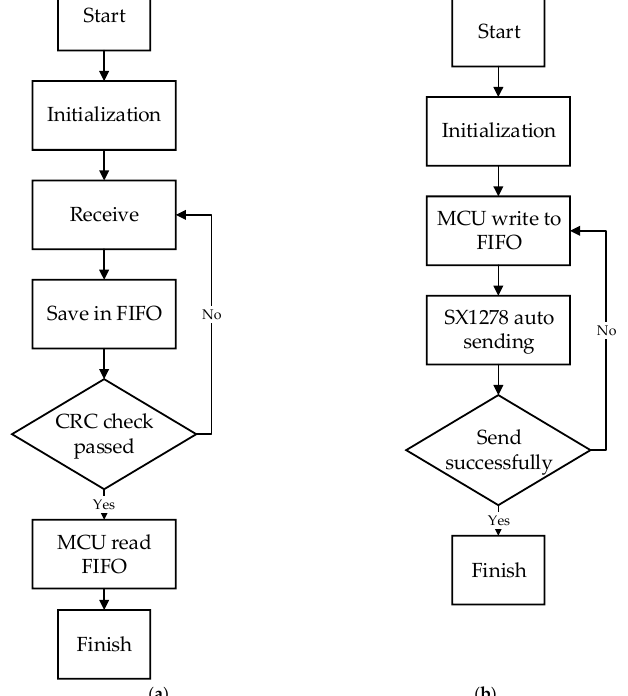
Figure 8. LoRa communication processing between the LoRaWAN chip SX1278 and the MCU of the main board. ( a ) LoRa receiving data. ( b ) LoRa sending data. CRC = cyclic redundancy check; FIFO = first input first output.